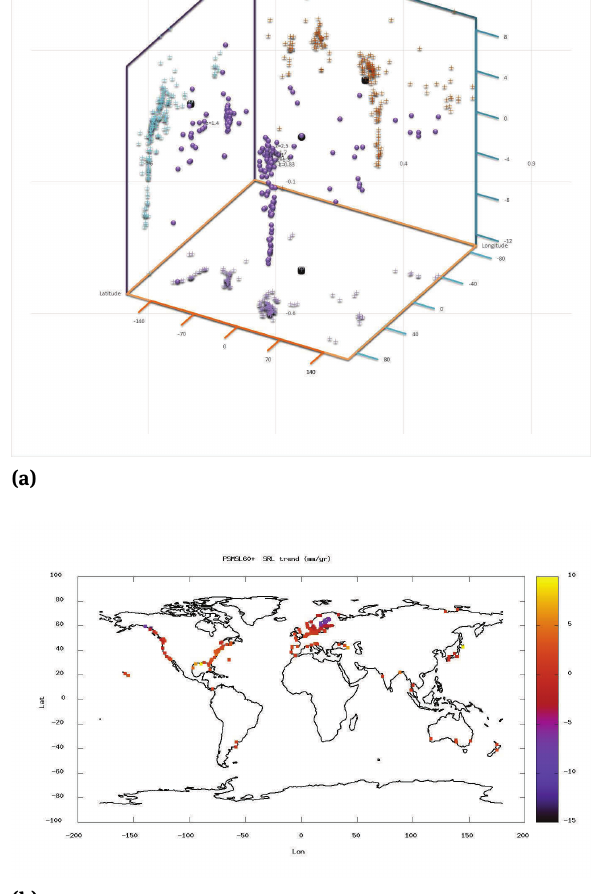
Figure5presentstheclassicaldeterminationoftherel- ative rate of rise by linear fitting in two of the oldest